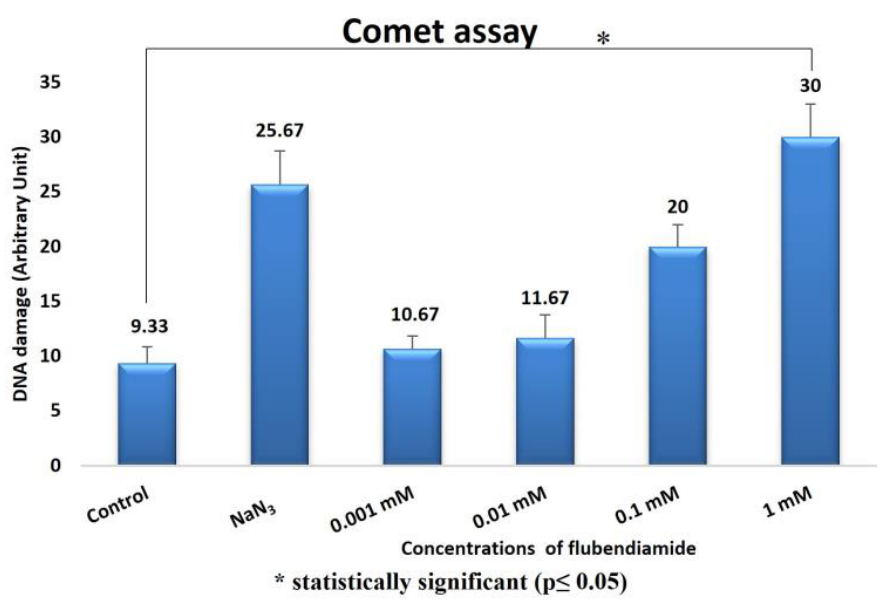
Figure 8. FLB-induced DNA damage scores in D. melanogaster .